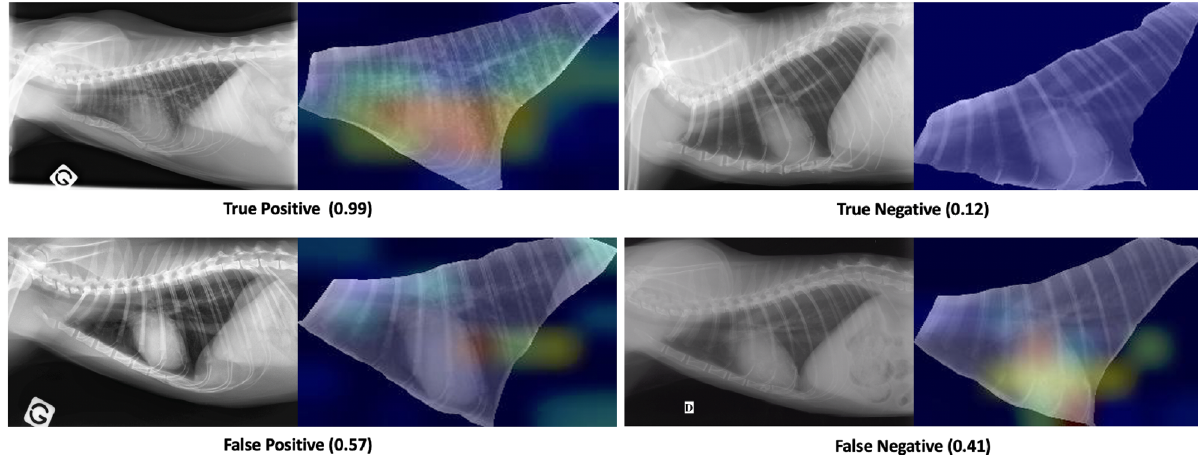
Figure 3. Examples of activation maps obtained with the pre-processing “Segmented“ on the test set, in comparison with the original TR image. The final prediction is indicated for each example. True Positive a TR image presenting a bronchial, interstitial and alveolar RPP in the caudal and accessory lobes in a context of chronic neutrophilic bronchopneumonia. True Negative a TR image without RPP realized after an impact with a car. False Positive a TR image without RPP in a context of accident on public way. False Negative a TR image with a focal bronchial RPP in the middle lobe, in a context of dyspnea. A zoom is applied for segmented TR images for representative